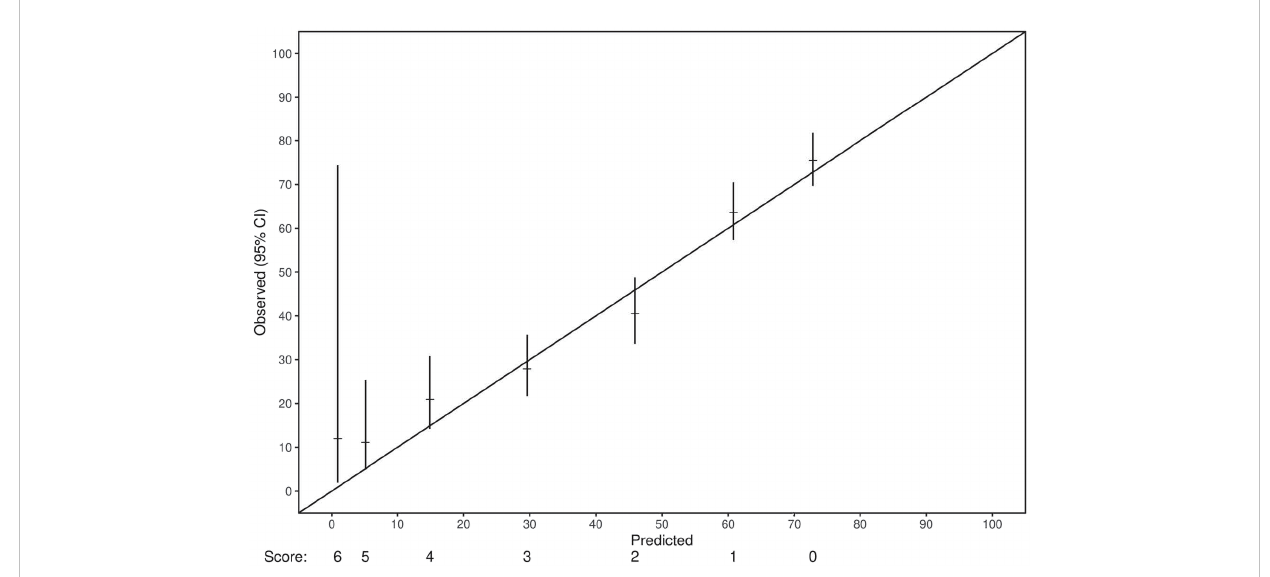
FIGURE 2 A demonstration of the adequacy of the validation set for each score of the fi nal prognostic model. For all scores but one, the number of events in the validation set fi t within the 95% con fi dence interval of the predicted event frequencies. The only exception was the score of 6, which only occurred 11 times in the training set and was, therefore, only a very small fraction of the fi nal prognostic